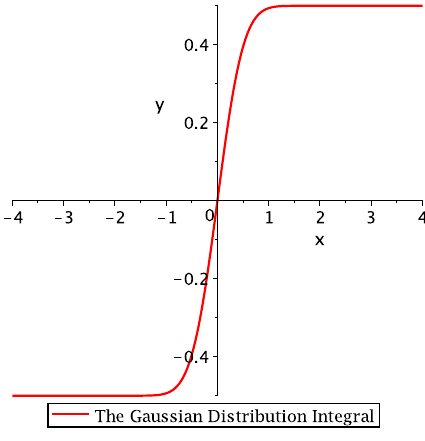
Figure 1: Gaussian integral (2) .